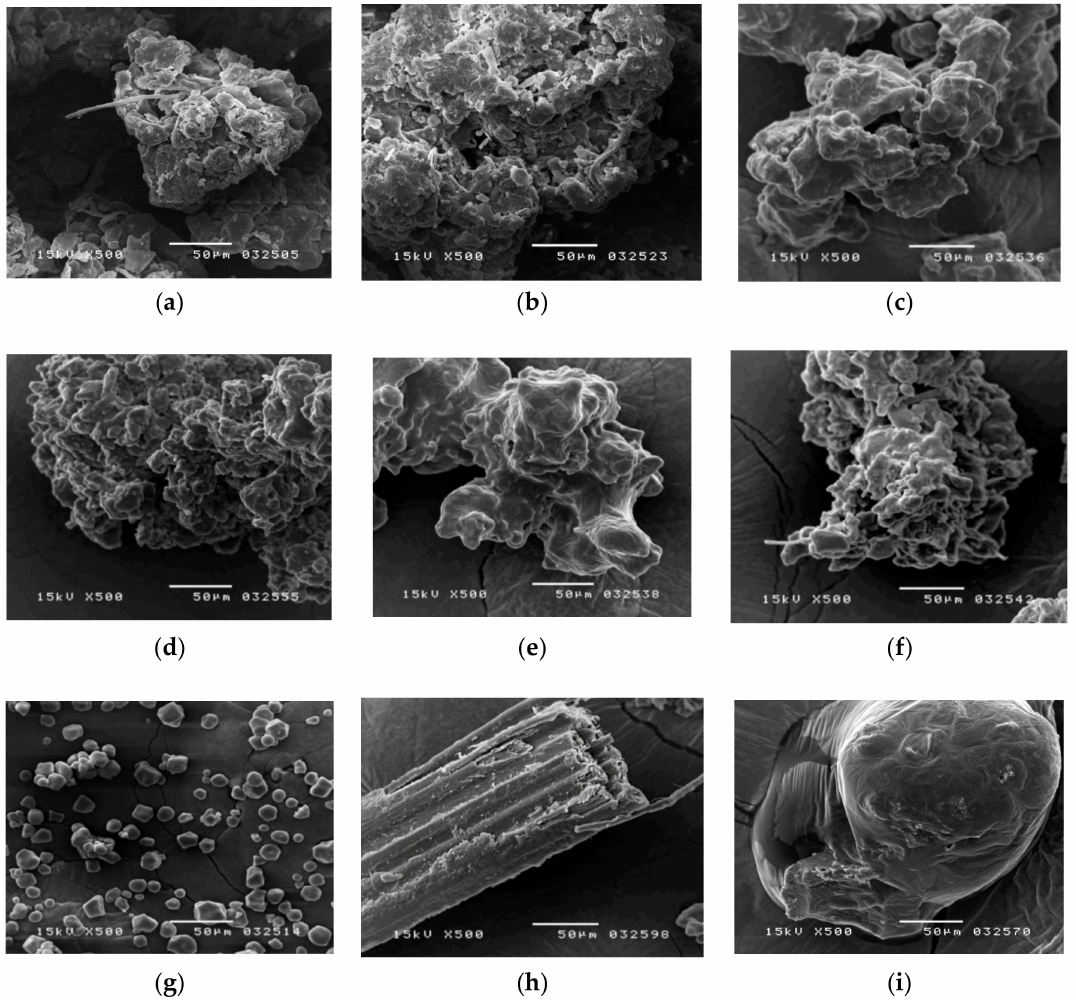
Figure 3. Scanning electron microscope photographs of the ( a ) herbal pharmaceutical product XSLJZT of brand A; ( b ) herbal pharmaceutical product XSLJZT of brand B; ( c ) herbal pharmaceutical product XSLJZT of brand C; ( d ) herbal pharmaceutical product XSLJZT of brand D; ( e ) herbal pharmaceutical product XSLJZT of brand E; ( f ) herbal pharmaceutical product XSLJZT of brand F; ( g ) cornstarch; ( h ) raw herbal powder; and ( i ) raw herbal extraction ( ×